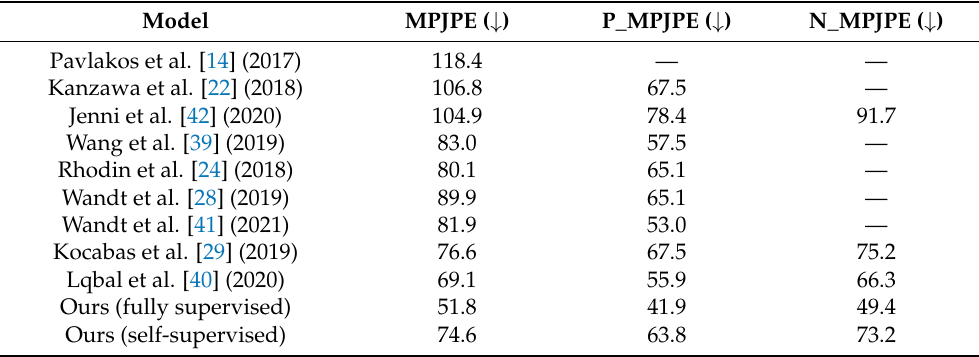
Table 2. Comparison of results between the proposed method and other weakly supervised and self-supervised